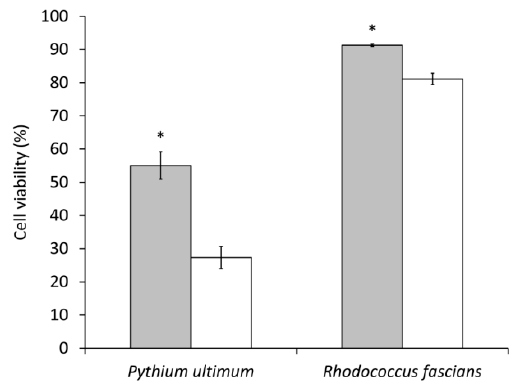
Figure 2. Antimicrobial activity of Lysobacter capsici AZ78 (AZ78) cell-free extracts. Relative percent of cell viability of Pythium ultimum and Rhodococcus fascians observed in response to AZ78 cell-free extracts (grey bars) and the references cycloheximide (100 μ g/mL) for P. ultimum and chloramphenicol (25 μ g/mL) for R. fascians (white bars). Mean and standard errors were calculated as the pool of three replicates from two independent experiments. Asterisks indicate significant differences according to Student’s t -test ( α = 0.05).